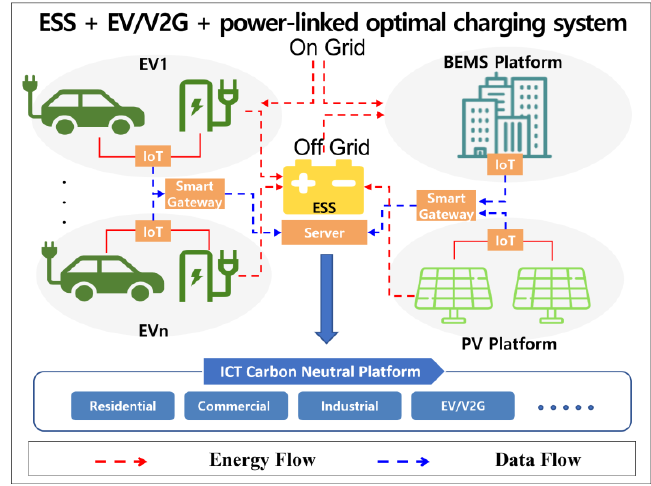
Figure 7. Construction of EV/V2G domain.